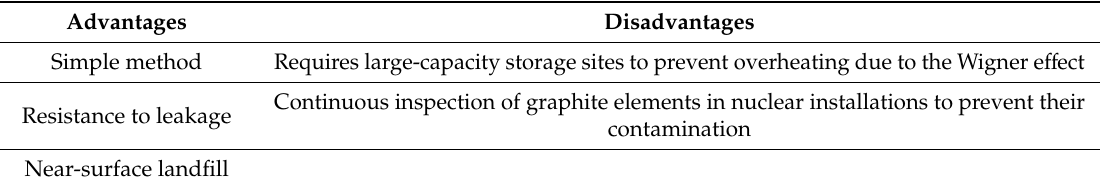
Table 3. Main features of the direct disposal of small graphite